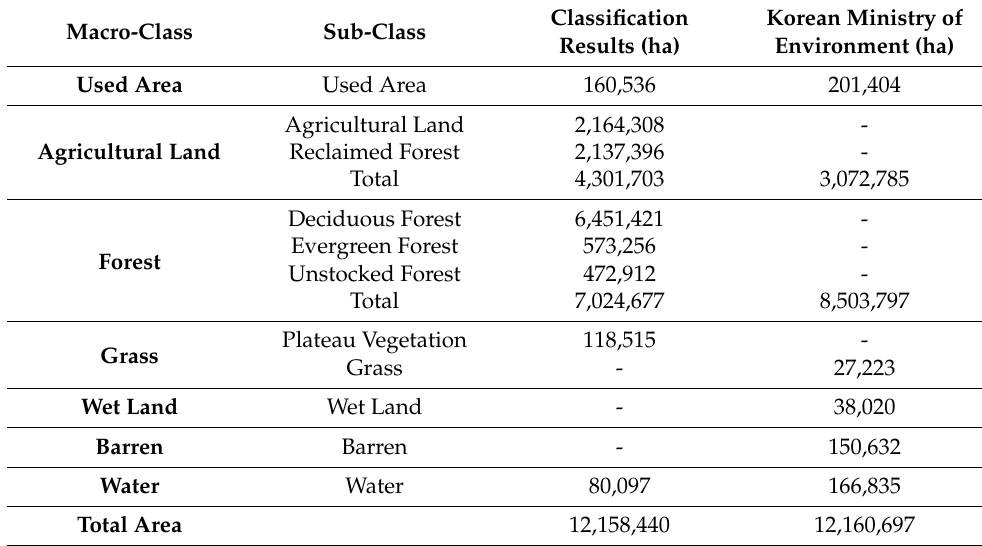
Table 2. Area calculation of classification results and comparison.